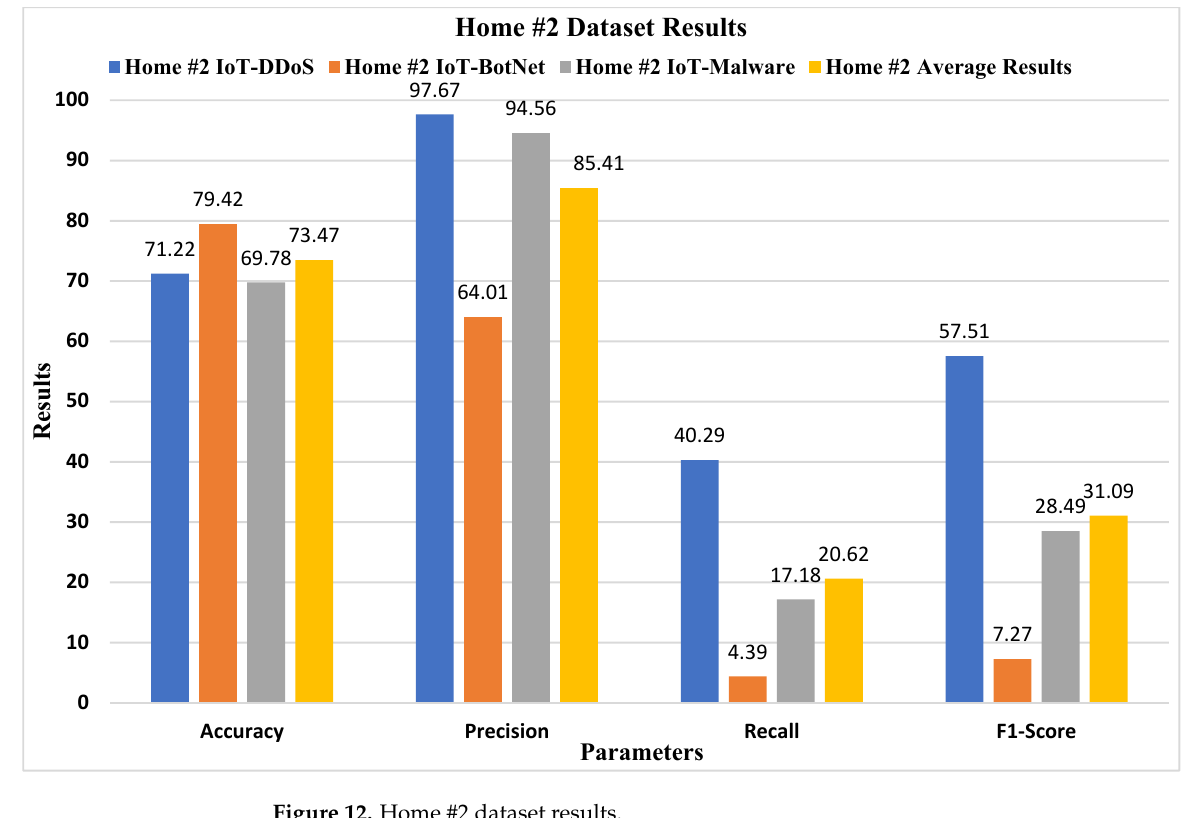
Figure 12. Home #2 dataset results.